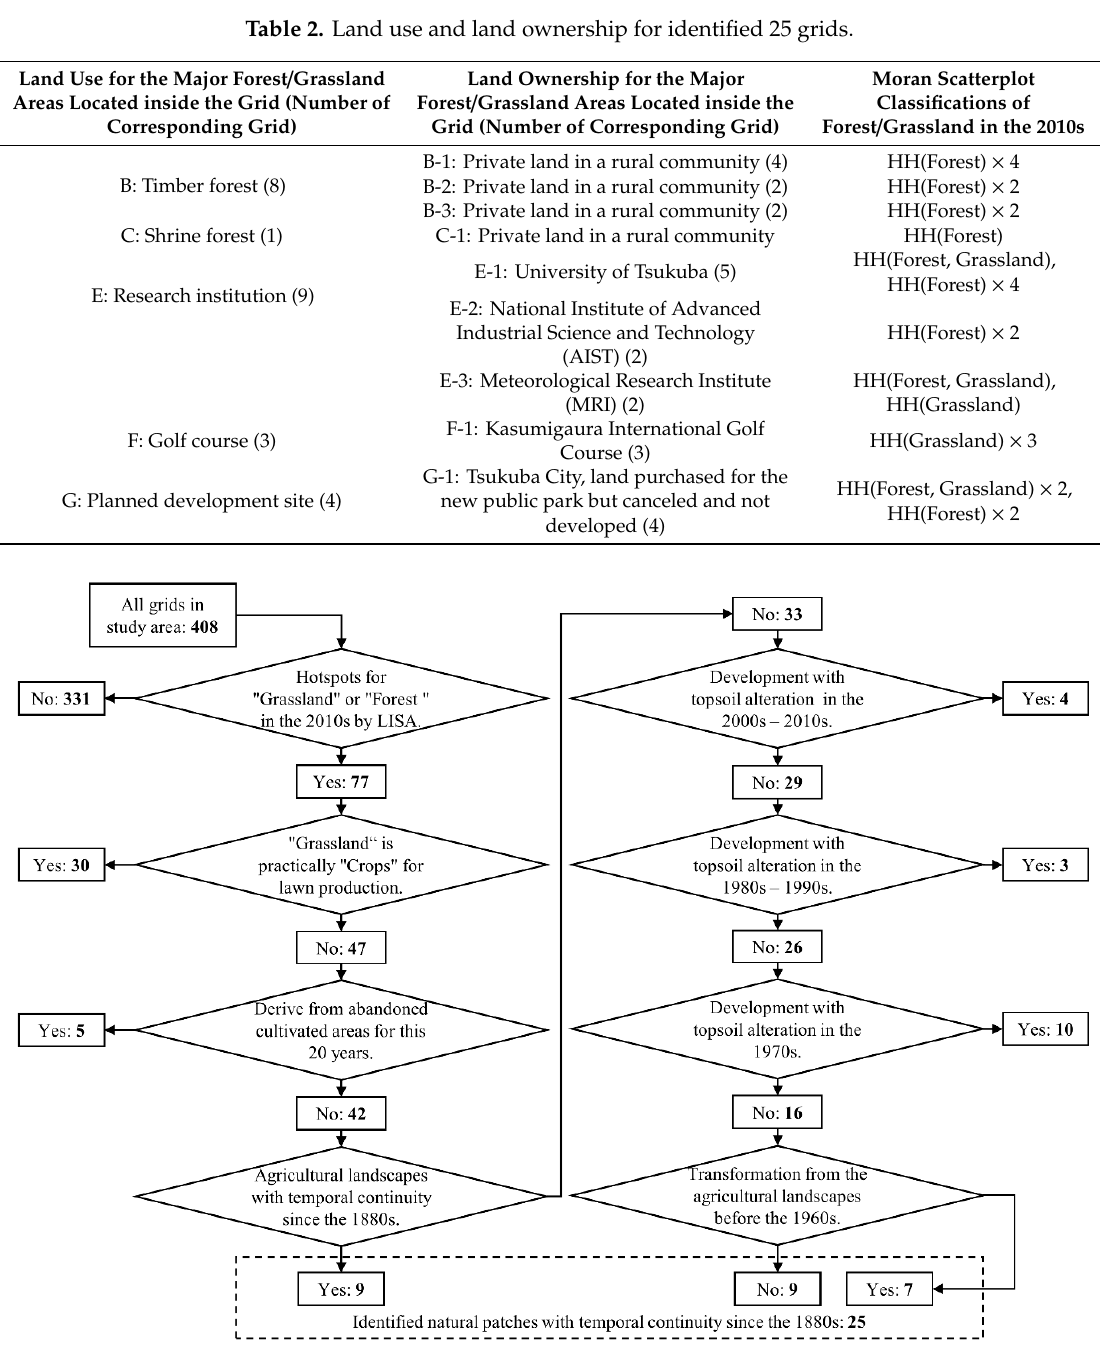
Figure 4. Flow chart for identifying the natural patches left in urban landscapes with temporal continuity since the 1880s. Table 2. Land use and land ownership for identified 25 grids.